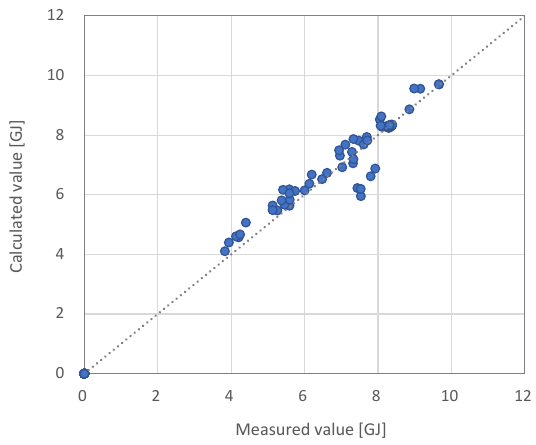
Figure 7. Verification of simulation accuracy.